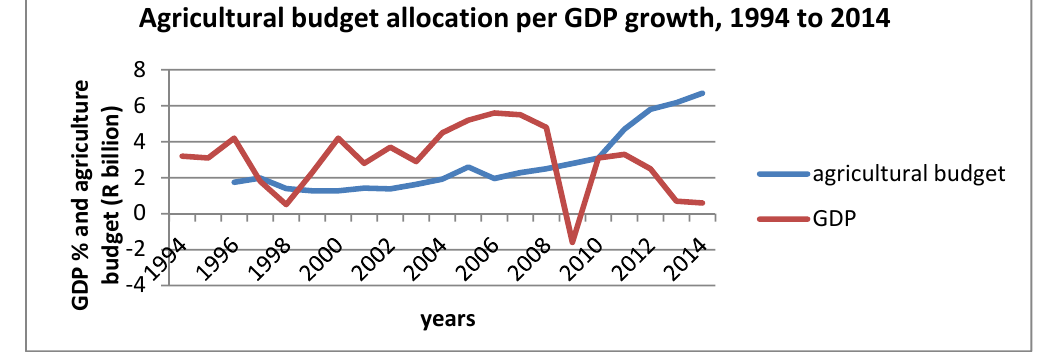
Fig. 3. Agricultural budget’s response to